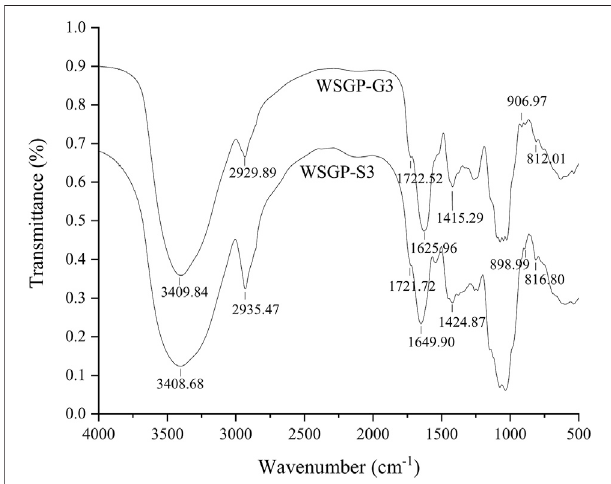
FIGURE 3 | FT-IR spectra of the polysaccharides WSGP-G3 and WSGP-S3.